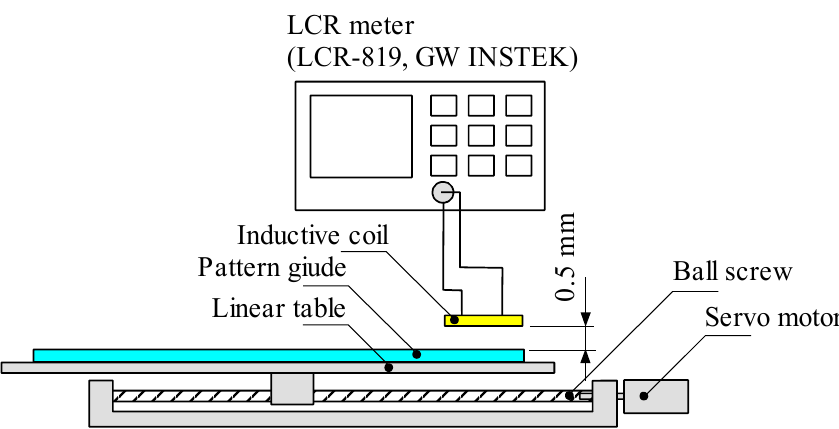
Figure 4. Measurement method of inductance at each